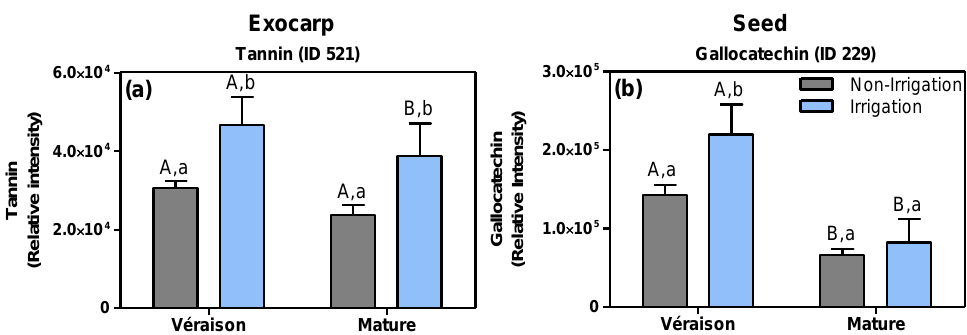
Figure 6. Relative abundance of ( a ) a tannin (ID 521) in the exocarp and ( b ) for gallocatechin (ID 229) in the seed, as obtained by LCMS analysis (means + SD, n = 8–12). Grape berries were grown under non-irrigation (grey bars) and irrigation conditions (blue bars) and collected at two developmental stages ( véraison and mature). Data of HL and LL berries, combined. Statistical test: two-way ANOVA, p ≤ 0.05. Statistical notation above the bars: the capital letters refer to differences between developmental stages for the same treatment condition, while the lowercase letters refer to differences between the control and irrigation treatment, within each developmental stage.